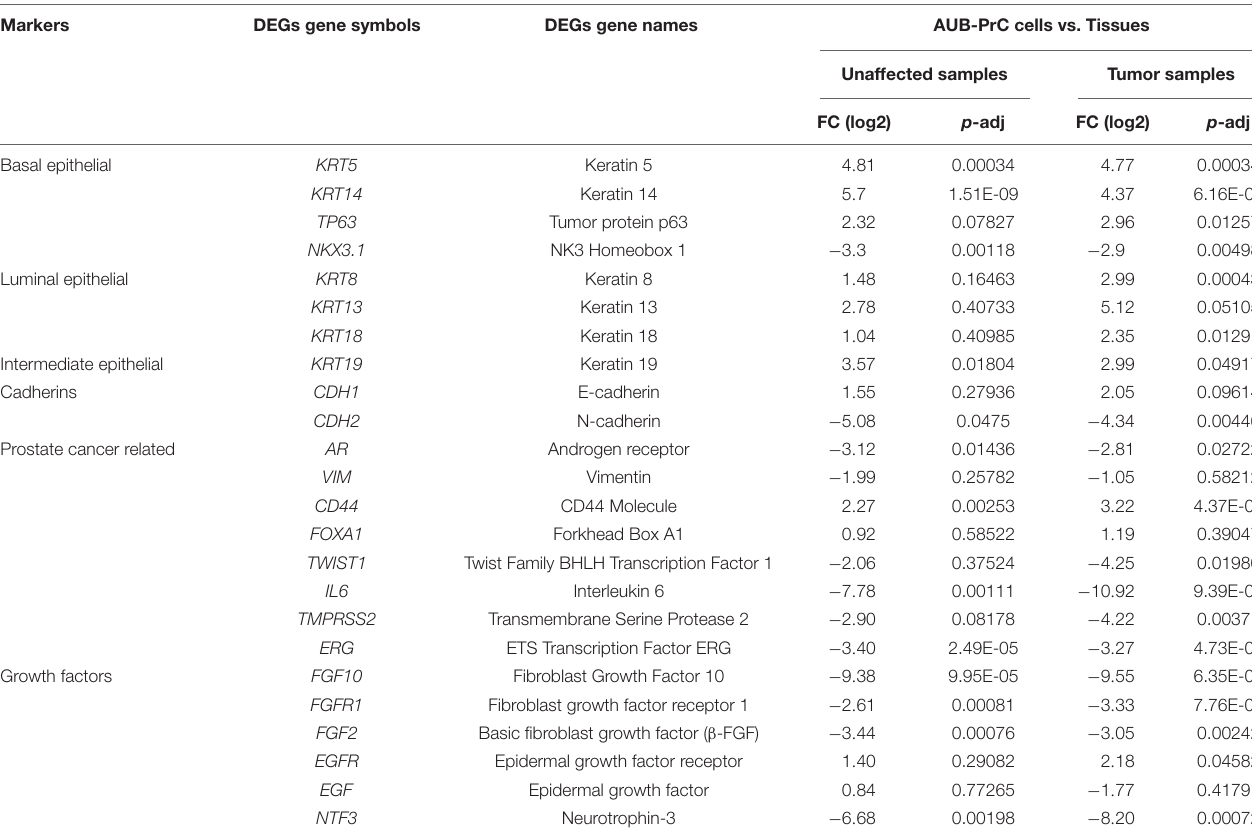
TABLE 1 | List of DEGs genes commonly representing prostate lineage markers and other markers related to prostate diseases along with their expression levels in AUB-PrC cells relative to their corresponding tissue counterparts in unaffected and tumor samples.